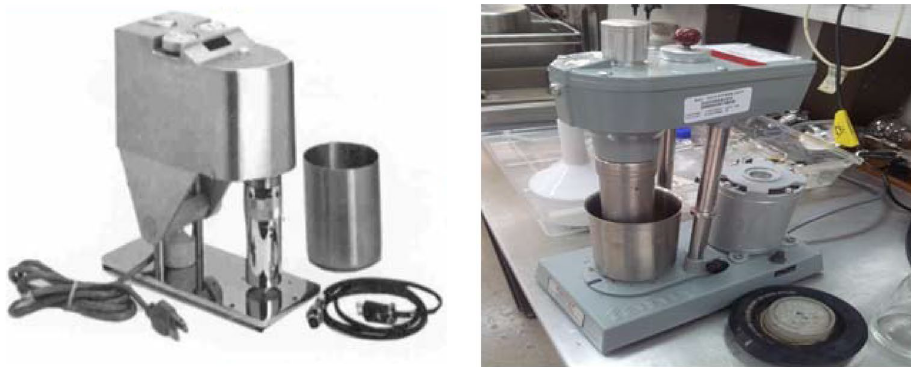
Fig. 1 Viscosity measuring